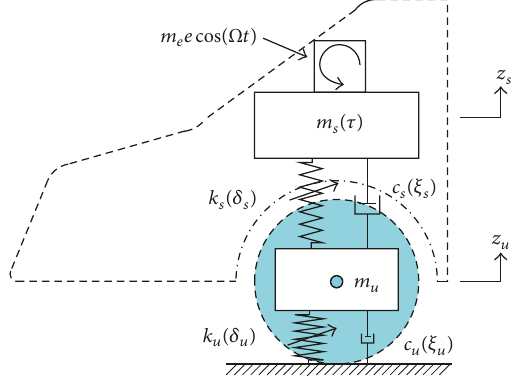
Figure 1: Nonlinear quarter-car